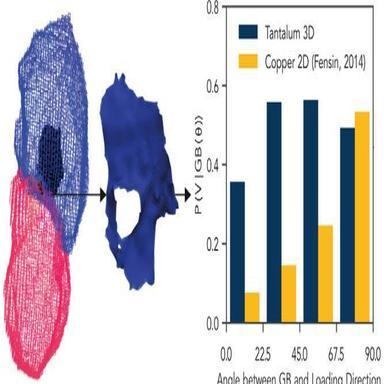
The probability of a grain boundary void forming at a given orientation of the grain boundary with respect to the loading direction, P(V|GB(θ )), along with a schematic description of the generation of such data in 3D. The 2D Cu data was taken from .